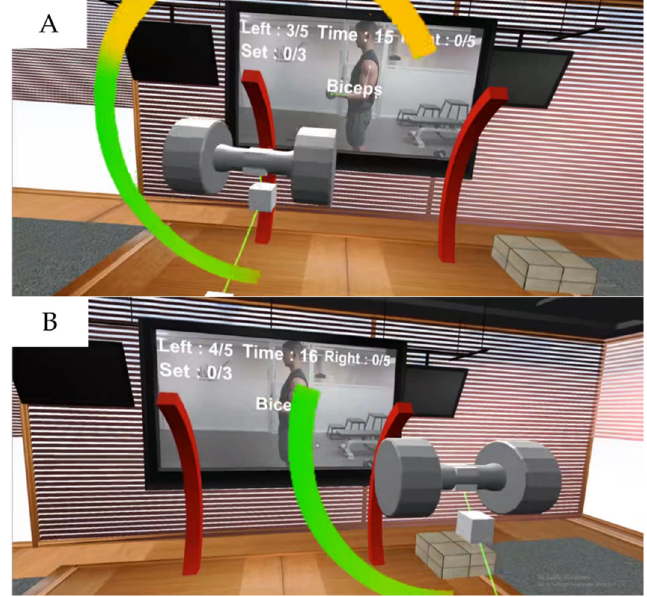
Figure 10. Dumbbell (bicep) curl process. ( A ) Left hand. ( B ) Right hand.